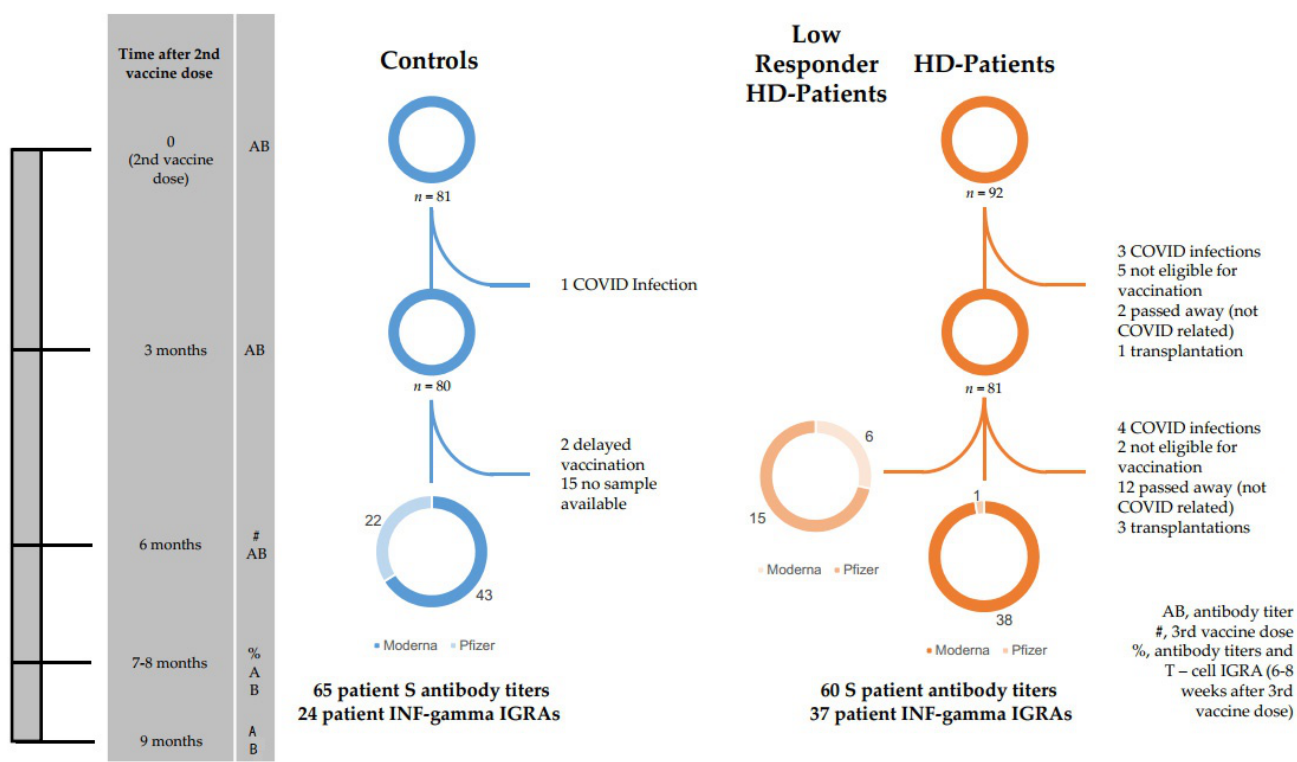
Figure 1. Patient flowchart. This flowchart is a graphical representation of the study design. The time axis on the left shows various significant time points in the study for easy orientation. The next column lists the events that occurred at each time point. Entries in this column are explained in the box at the bottom right of the flowchart.